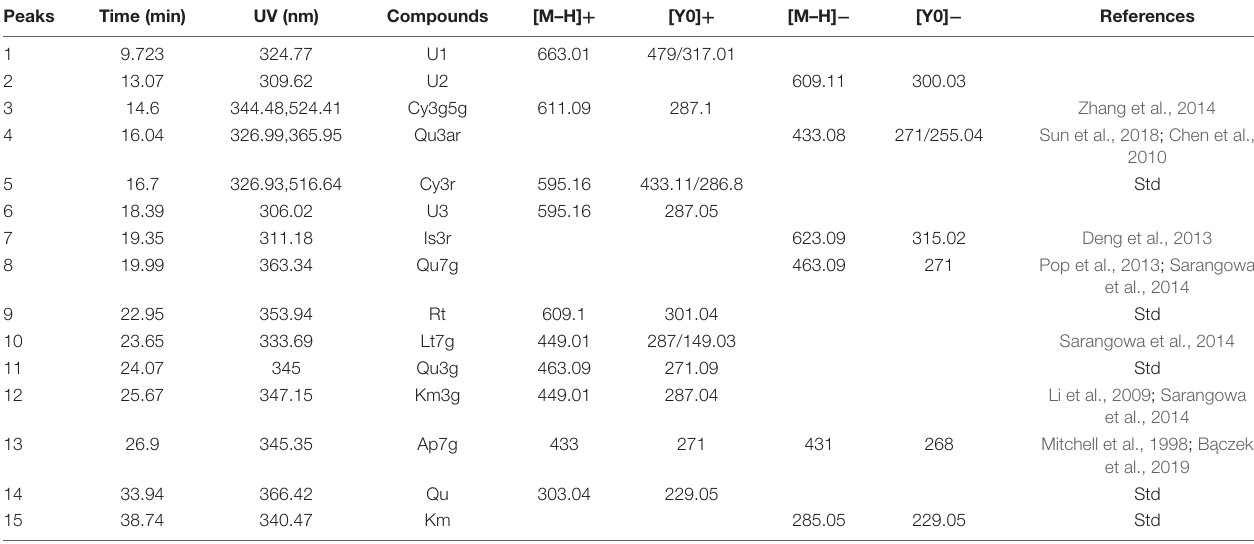
TABLE 2 | Chromatographic, spectroscopic, and mass spectrometric features of flavonoids detected in this study. Peaks Time